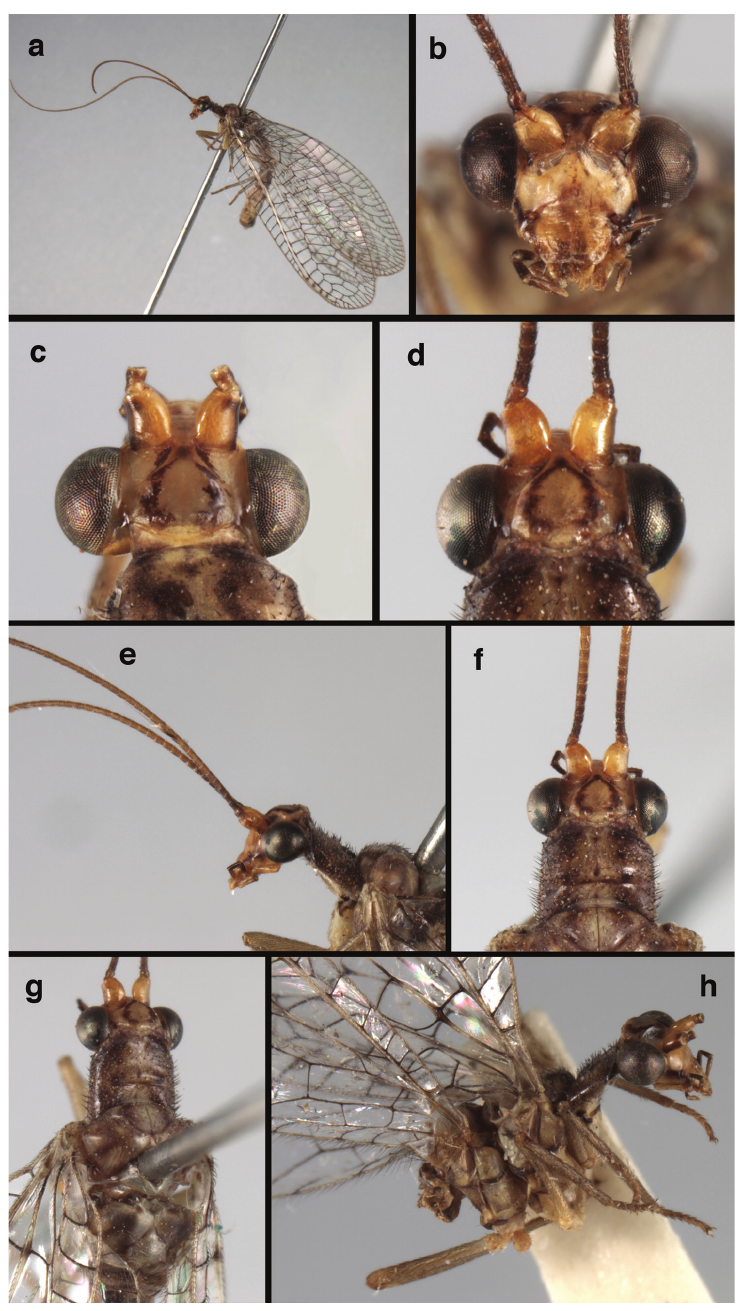
Figure 98. Ungla annulata Navás: External features, ( a ) habitus, lateral ( b ) head, frontal ( c, d ) head, dorsal [Note variation in markings on scape and vertex.] ( e ) head, prothorax, lateral ( f ) head, prothorax, dorsal ( g ) head, thorax, dorsal ( h ) head, thorax, lateral (all: Argentina, Salta, female; a, d–g USNM; b, c, h